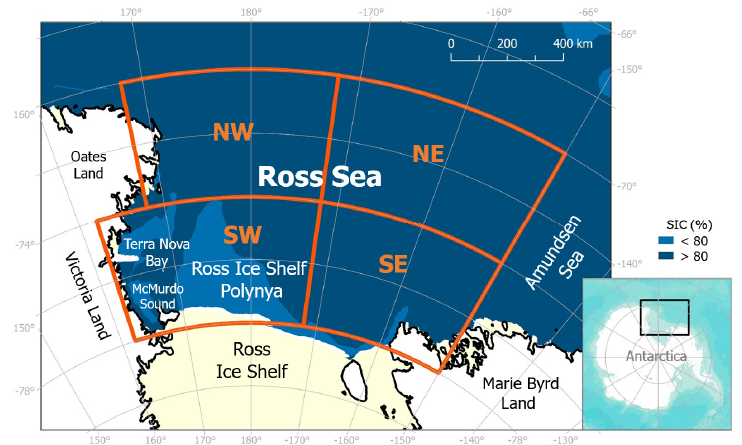
Figure 2. Map of the Ross Sea showing the four subsectors of interest (northwest—NW, northeast—NE, southwest—SW, and southeast—SE) for this study superimposed on a sea ice concentration (SIC) for October 2019 from the U.S. National Ice Center (NIC) ice chart. The three low SIC areas inside the SW are the three known polynyas: the Ross Ice Shelf Polynya (RISP), Terra Nova Bay Polynya (TNBP), and McMurdo Sound Polynya (MSP).